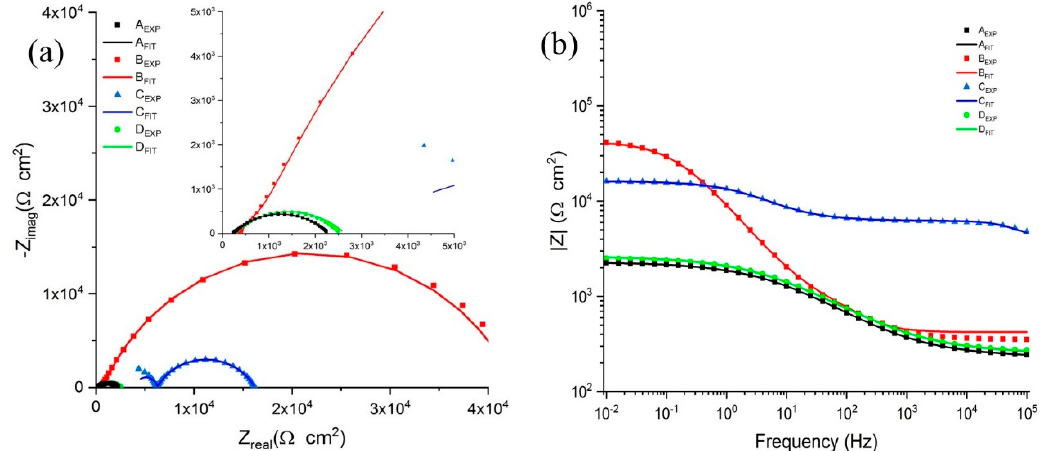
Figure 9. ( a ) Nyquist and ( b ) bode diagrams of the scratched samples immersed in the HCl solution for 8 days.